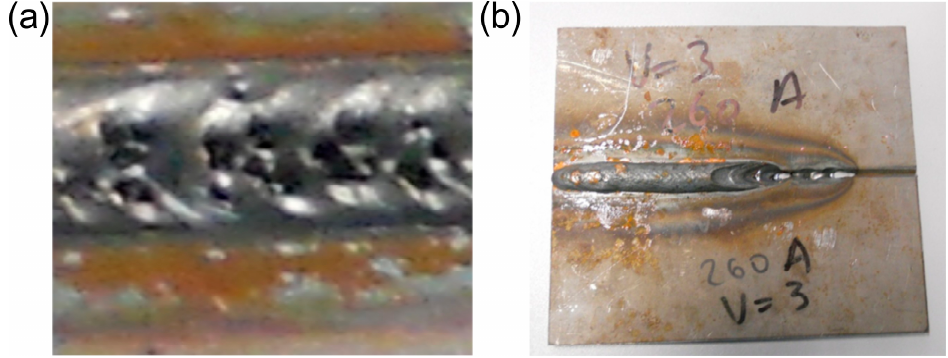
Figure 8. ( a ) Pores in the weld cord due to incorrect values of flow rate of the shielding gas and the orientation of the electrode. ( b ) Melting of the base metal due to excessive heat supplied to the welding